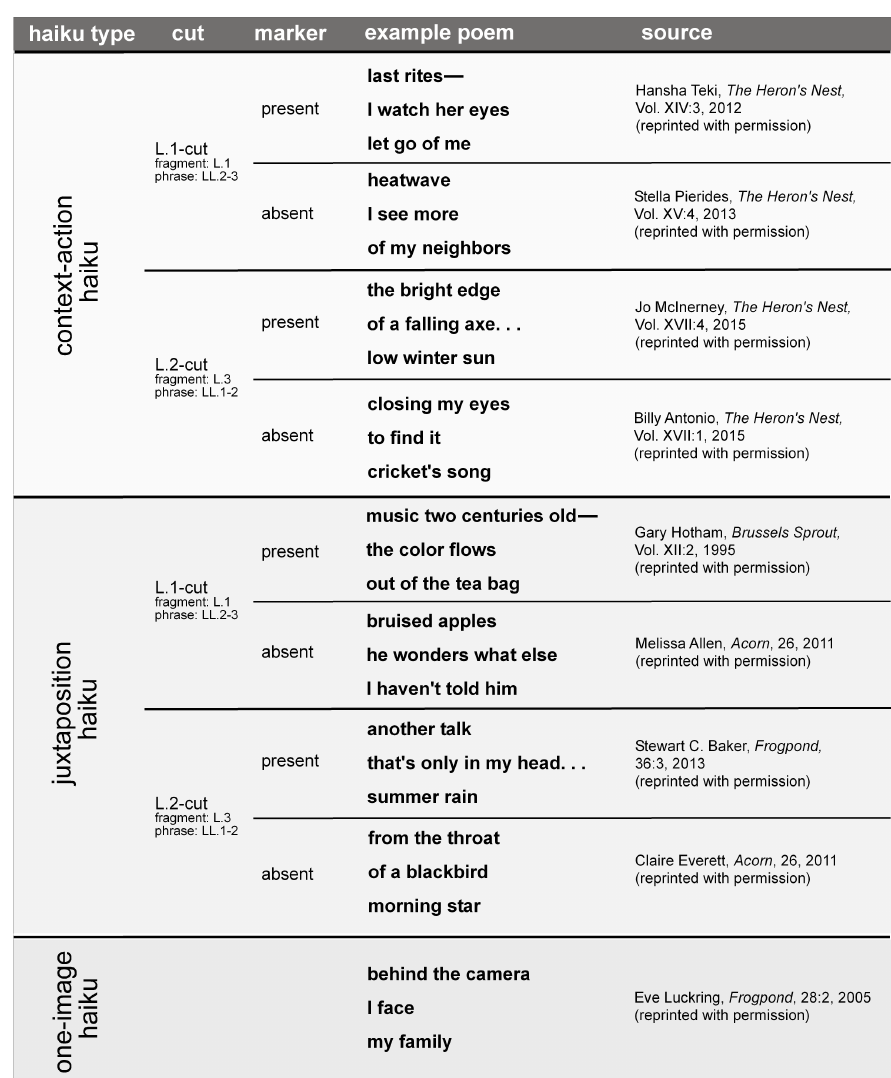
Figure 1. Example haiku from the sample used in the study, for each of the eight haiku type × cut position × cut marker conditions. In context–action haiku, one component (image) of the haiku, the fragment, provides the context (take, for example Hansha Teki’s, 2012, poem: [ fragment ] “last rites–“) and the other, the phrase, describes an action set within this context ( [ phrase ] “I watch her eyes / let go of me”). Both images, although each relatively familiar, are set in a relationship with one another by the poet. In juxtaposition haiku, by contrast, there is no straightforward (familiar) context–action relationship, that is, the images juxtaposed are more jarring, in a relationship of tension that needs to be resolved (e.g., Melissa Allen’s, 2011: [ fragment ] ”bruised apples /” [ phrase ] “he wonders / what else I haven’t told him”). The cut can either be at the end of line 1 (L.1-cut, i.e., the fragment part is in line 1) or at the end of line 2 (L.2-cut, i.e., the fragment is in line 3). Further, cut effects can be reinforced by punctuation (i.e., explicit cut markers) at the end of the fragment line 1 (L.1-cut haiku) or central line 2 (L.2-cut haiku). In the present study, reading behavior was also assessed in a control condition: one-image haiku (e.g., “behind the camera / I face / my family”, Eve Luckring, 2005) with only a single picture/image, i.e., without tension between conflicting background and foreground elements (fragment and phrase lines in haiku, differences differences that are not characteristic/defini- tional of the different haiku types compared.